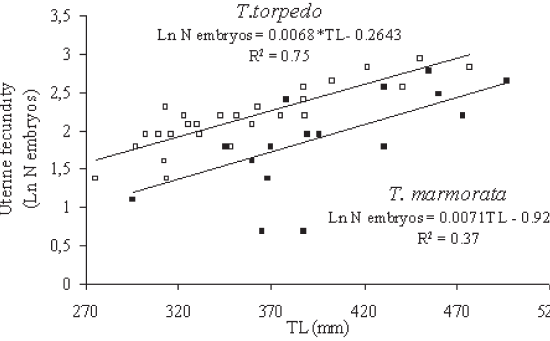
F IG . 8. – Relationship between uterine fecundity and total length in T. torpedo ( (cid:2) ) and T. marmorata ( (cid:3)